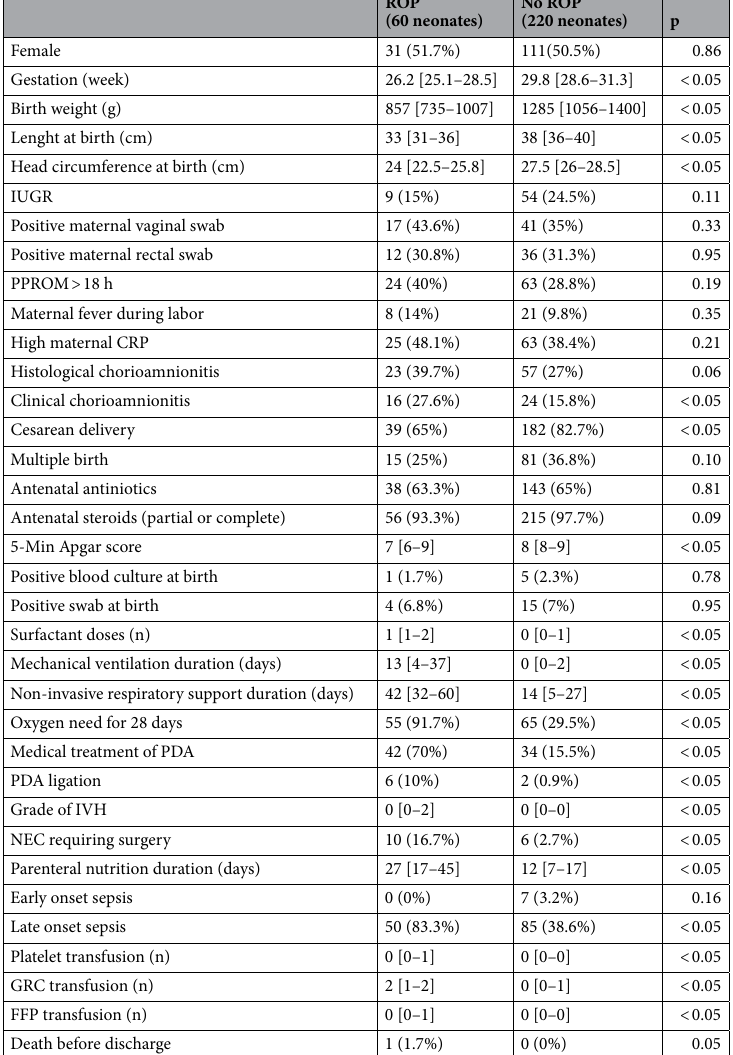
Table 2. Clinical characteristics of the two cohorts of neonates with and without ROP. Values are presented as median [IQR], and count